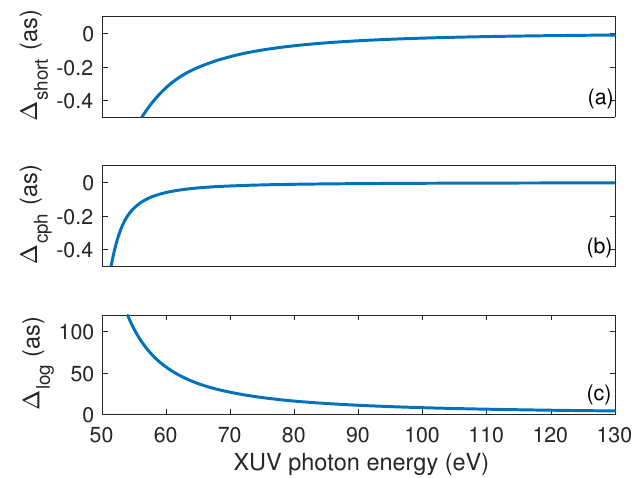
Figure 4. Absolute difference for the different contributions to the time delay of neon atom with and without the effect of the streaking field as a function of electron energy and streaking field wavelength: ( a ) short-range contribution; ( b ) Coulomb phase contribution; and ( c ) Coulomb logarithmic contribution. Parameters of the streaking field: wavelength λ s = 800 nm, peak intensity I s = 1 × 10 12 W/cm 2 , and pulse duration of three cycles is used